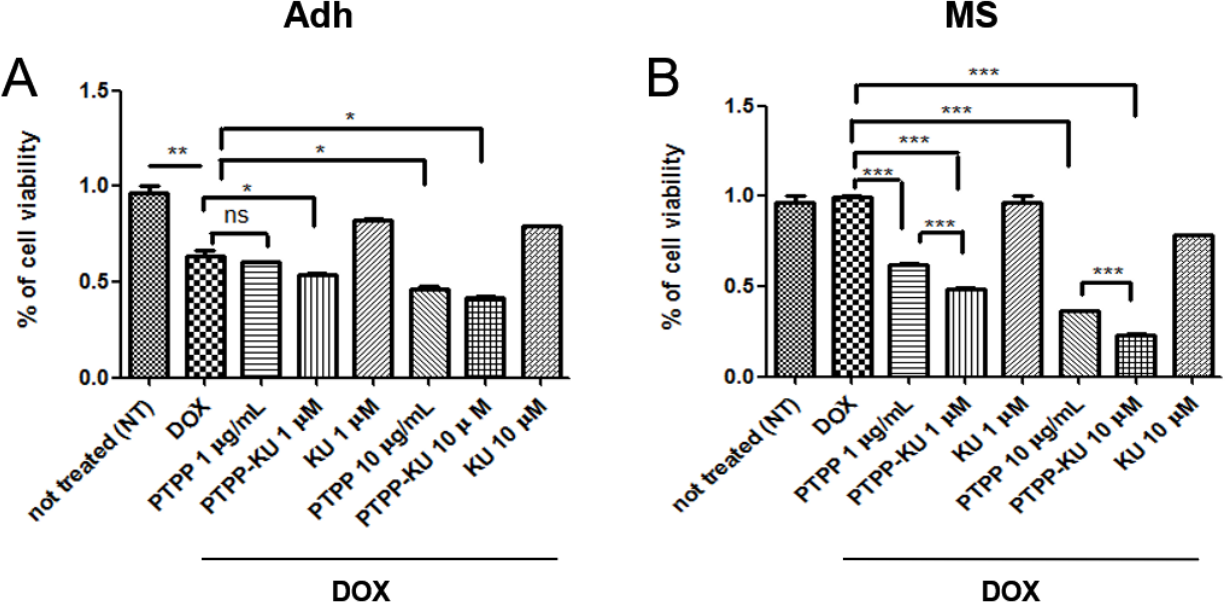
Figure 1. PTPP–KU sensitization of mammospheres to doxorubicin compared with non-treated (NT) cells. Cell viability of the MCF-7 cell line grown ( A ) in adherent (Adh) and ( B ) in mam- mosphere (MS) conditions. Cells were treated with 1 μΜ of doxorubicin (DOX) for 3 h and various doses of free KU-55933 (KU), PTPP–KU, and PTPP (administered 30 min before adding DOX), as indicated. After 24 h, cell viability was measured using an MTS assay. The results are expressed as the mean ± SD for at least three independent experiments and were analyzed using a Student’s t - test (* p < 0.05, ** p < 0.01, *** p < 0.001, ns not significant).